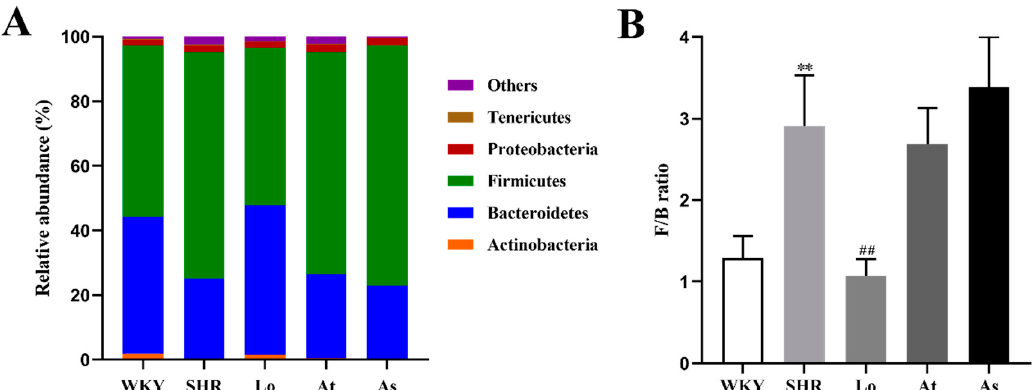
Figure 6. The abundances of the five most abundant phyla in the gut microbiota in rats and F/B ratio. ( A ) The abundances of the five most abundant phyla in the gut microbiota in rats. ( B ) The F/B ratio. The data are presented as the mean ± SD, n = 6. ** p < 0.01 vs. WKY; ## p < 0.01 vs. untreated SHR. Table 1. The abundance of the five most abundant phyla in the gut microbiota in rats. Phylum WKY SHR Lo At As